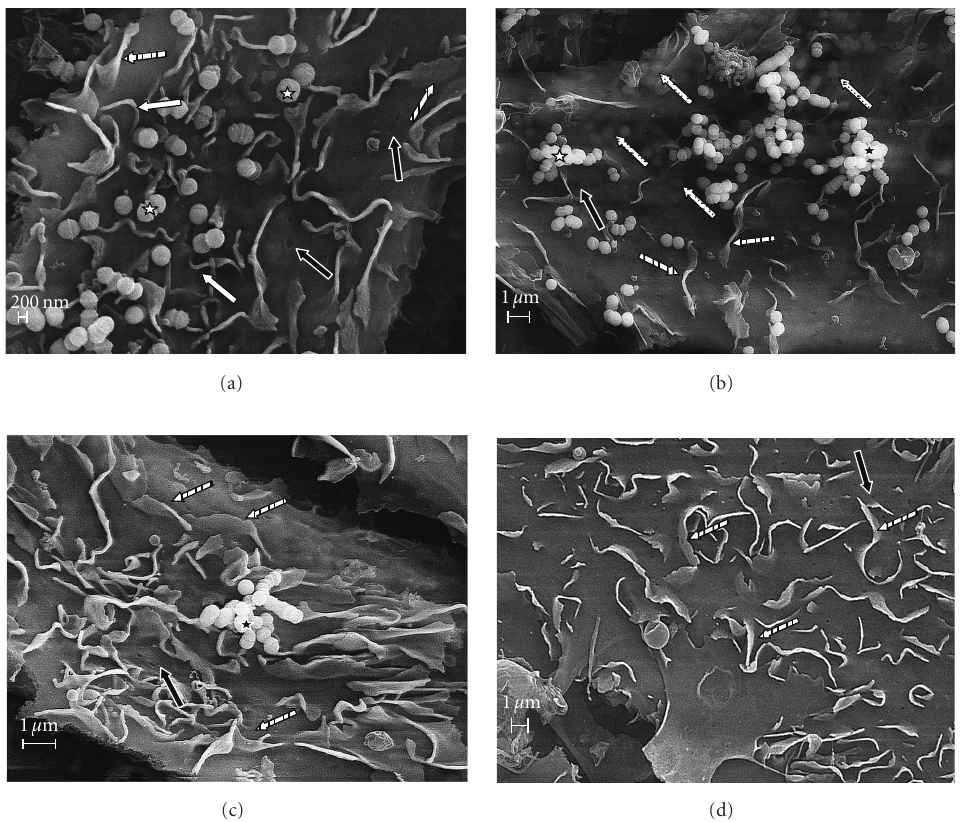
Figure 6: Scanning electron microscopy (SEM) of cocultures of bovine mammary epithelial cells with untreated S. uberis . Untreated Streptococcus uberis was cocultured with bovine mammary epithelial cells and observed using SEM at di ff erent incubation times (a)–(c). Upon contact with S. uberis ( ∗ ) bovine mammary epithelial cells did not reacted abundantly as seen with S. uberis pretreated with fibronectin, collagen, or bovine lactoferrin. Although filopodia (white arrows) and flap-like structures (stripped arrows) were detected, these structures were also observed in MAC-T cells not cocultured with S. uberis (d). Even though cell membrane invaginations (black arrows) as well as S. uberis internalization (dot-filled arrows) were detected, neither flap-like structures engulfing bacteria nor filopodia sticking or covering S. uberis were